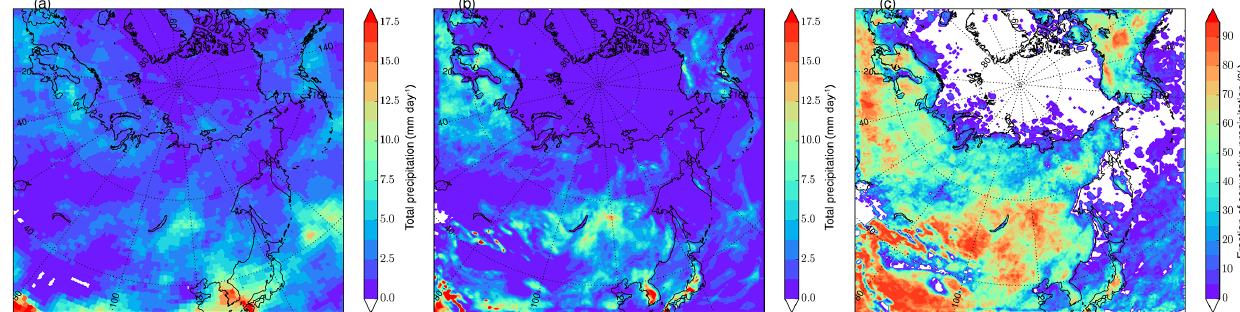
Figure 5. Average precipitation from period 4–21 July (a) obtained from 1 ◦ daily GPCP data and (b) simulated by WRF-Chem. The fraction of convective precipitation is shown in panel (c)